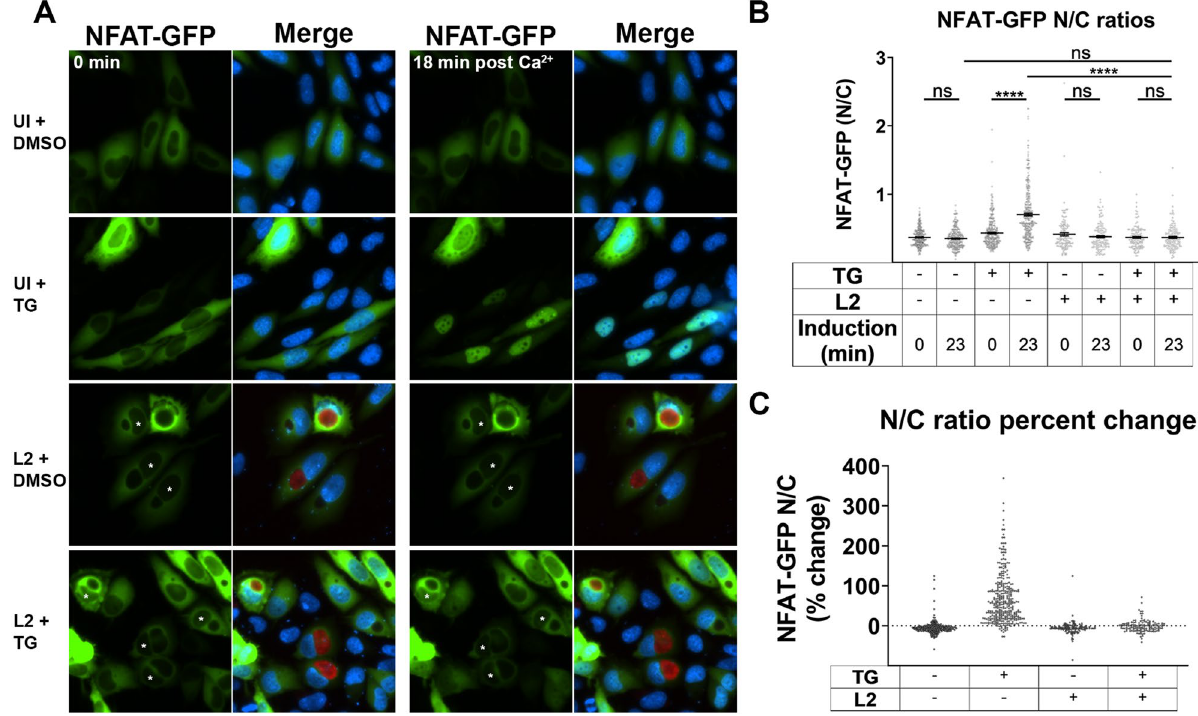
Figure 4. NFAT nuclear localization is diminished in C. trachomatis -infected cells. Nuclear translocation of NFAT-GFP was assessed in C. trachomatis L2 infected and uninfected HeLa cells. ( a ) Cells expressing NFAT- GFP were induced with thapsigargin (TG) to trigger SOCE or treated with the DMSO vehicle control for 5 min. Cells were imaged at 0 min post-addition of TG or DMSO, and then imaged at 18 min after administering Ca 2+ -containing Ringer’s solution. Asterisks denote the nuclei of C. trachomatis -infected cells. ( b )